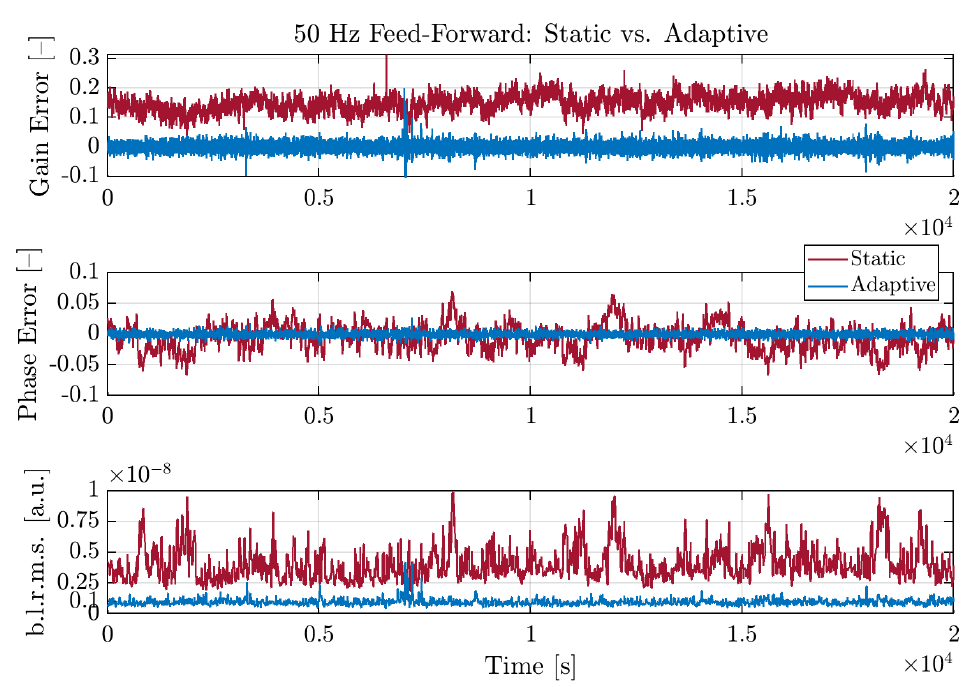
Figure 4. 50Hz Feed-Forward: Improvement of the band RMS around 50Hz of the DARM error signal by using an adaptive control strategy. From top to bottom: error signal for the gain and phase of the feed-forward control; band RMS of DARM around